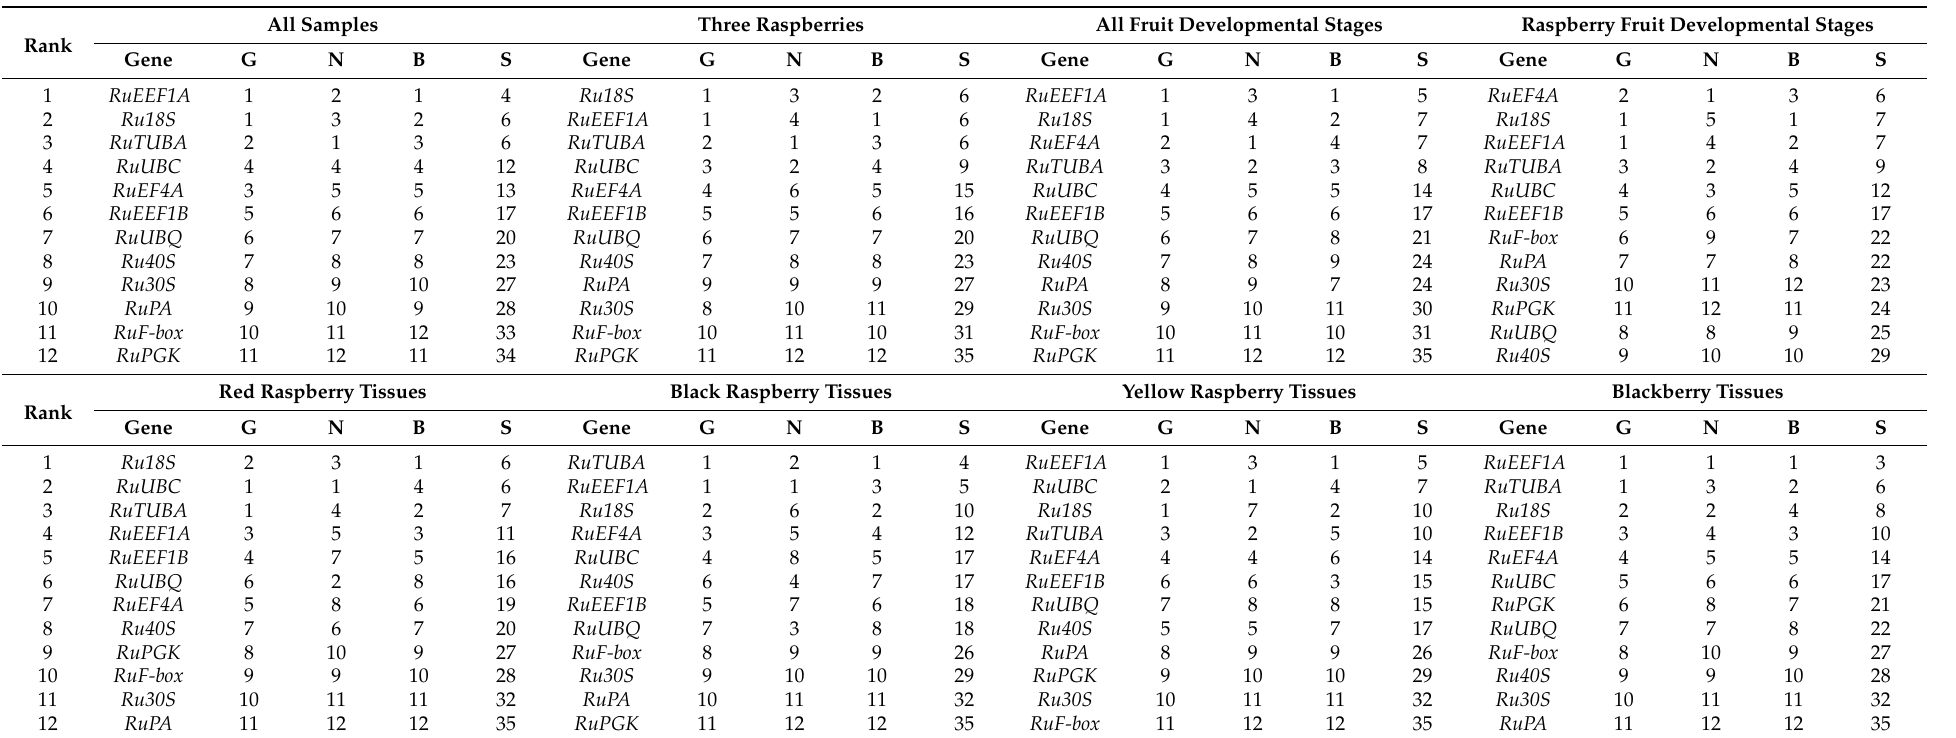
Table 3. Comprehensive analysis and ranking of 12 candidate reference